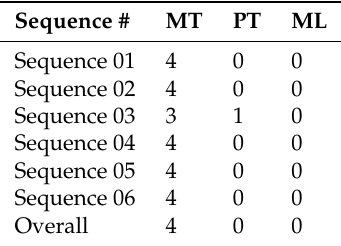
Table 3. Results for track quality measures Mostly track (MT), partially tracked (PT), and mostly lost (ML). Sequence # MT PT ML Sequence